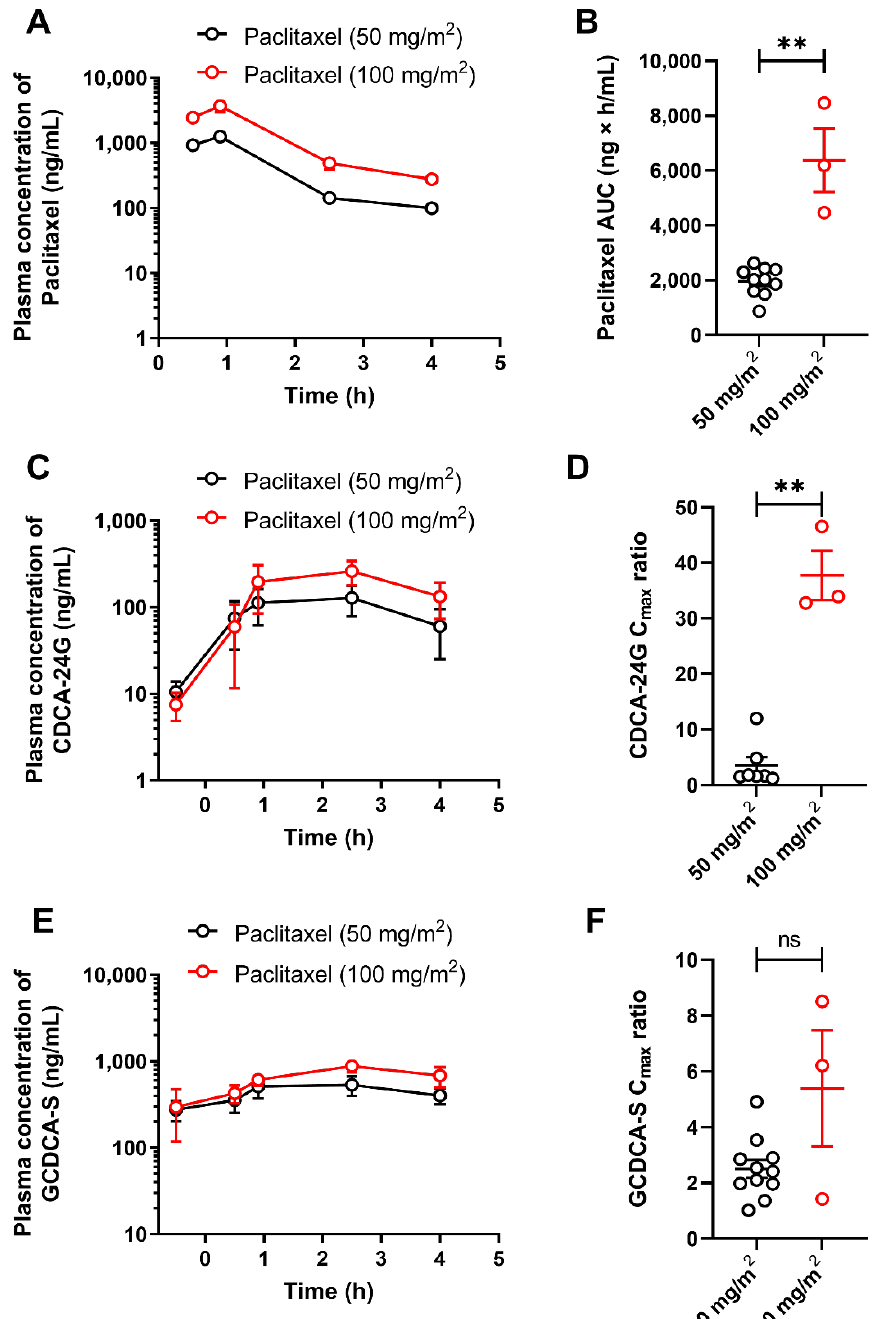
Figure 3. Influence of paclitaxel (Taxol) on OATP1B biomarkers. Plasma concentrations ( A ) and AUCs ( B ) of paclitaxel in patients after i.v. infusion of paclitaxel at a dose of 50 or 100 mg/m 2 . Plasma concentrations ( C ) and C max to baseline ratio ( D ) of CDCA-24G, and plasma concentrations ( E ) and C max to baseline ratio ( F ) of GCDCA-S in the same patients, ** p < 0.01, ( n = 3–11). All data are presented a mean ± SEM.